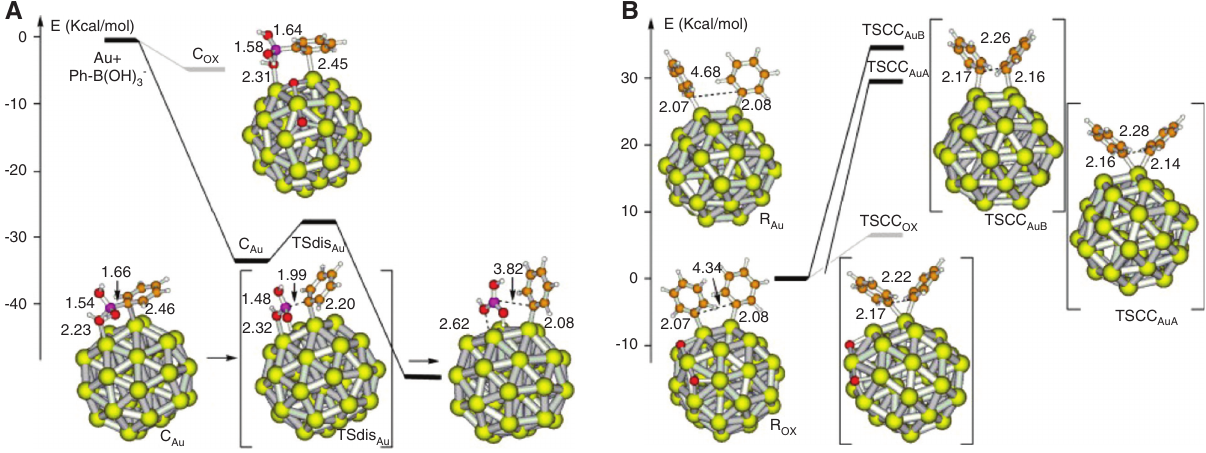
Au , anion and (B) coupling of two phenyl fragments yielding biphenyl on a 20 nanoparticle (i.e., carrying two oxygen atoms) (gray line). The optimized 38